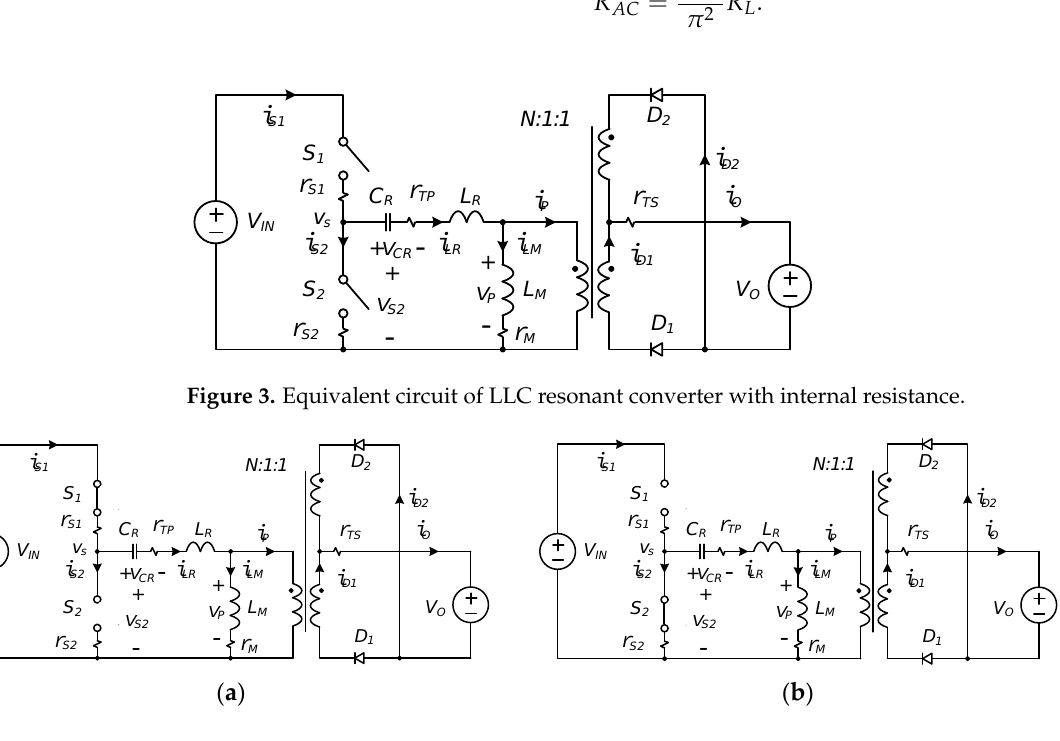
Figure 4. Equivalent circuit for each state of the LLC resonant converter in steady-state: ( a ) When switch S1 is turned on; and ( b ) when switch S2 is turned